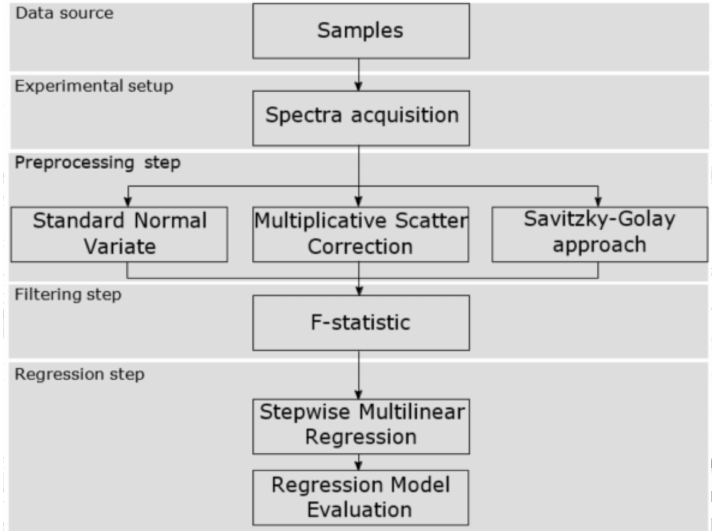
Figure 1. Workflow followed for our approach.